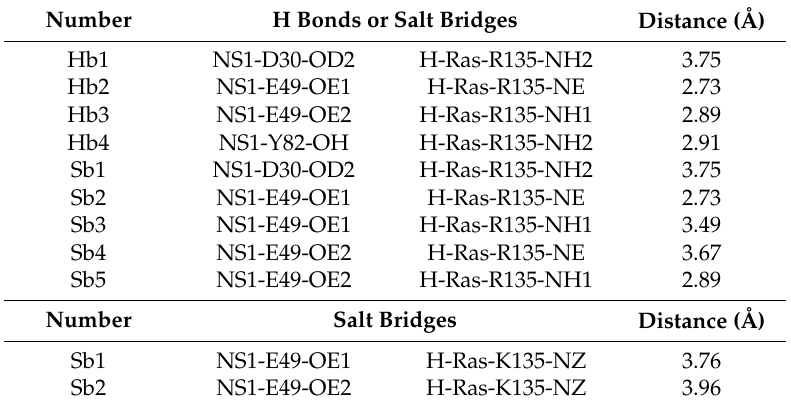
Table 2. Summary of the hydrogen bonds and salt bridges between R135 and NS1 in wild type (up) and R135K (down)